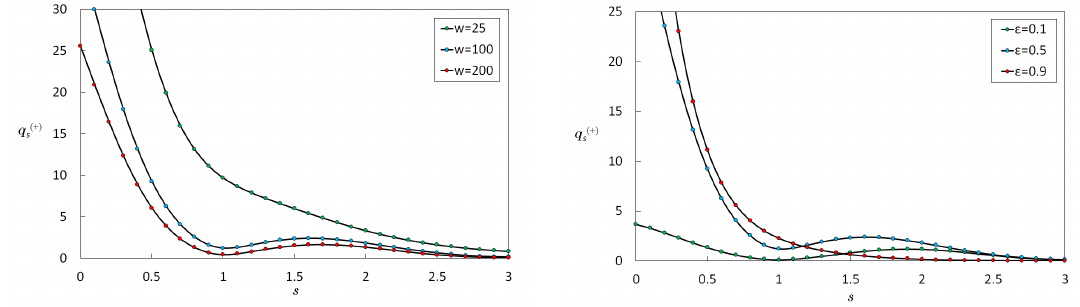
(+) = 0.5. ( Right ) ε changes, s on s . ( Left ) w changes, ε